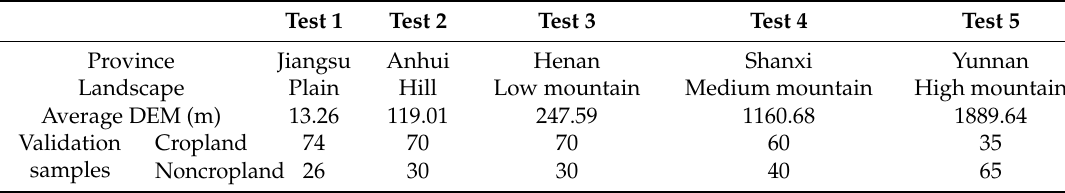
Table 4. The experiment design of the influence of various